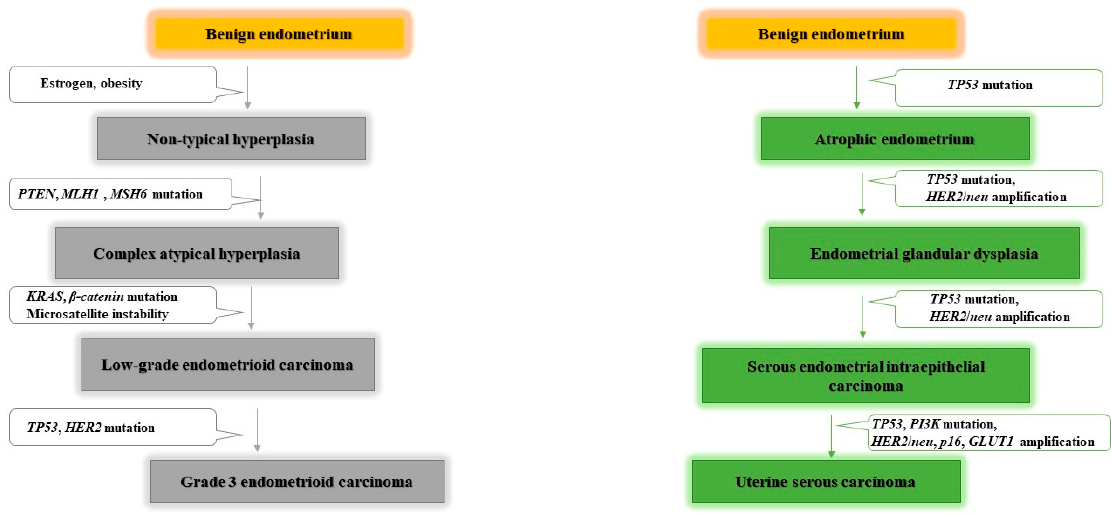
Figure 1. Commonly altered genes in endometrial carcinogenesis. Endometrioid carcinoma is estrogen dependent, and obesity is associated with an elevated endometrioid cancer risk and mortality. Several mutations can lead to initiation and development of endometrioid carcinoma, such as PTEN , KRAS and β -catenin mutations, wheras non-endometrioid carcinoma more often harbours mutations in TP53 . PTEN : phosphatase and tensin homolog. MLH1 : human mutL homolog 1, involved in DNA mismatch repair. MSH6 : human mutS homolog 6, involvedd in DNA mismatch repair. KRAS : KRAS proto-oncogene, GTPase. β -catenin : CTNNB gene (cadherin associated protein) a signaling molecule involved in the control of cell growth and differentiation. TP53: tumour protein p53, tumour supressor. HER2/neu : Erb-B2 receptor tyrosine kinase 2, proto-oncogen. PI3K: phosphatidylinositol 3-kinase, proto-oncogen. P16: cyclin-dependent kinase inhibitor 2A gene, tumour supressor. Glut1: glucose transporter